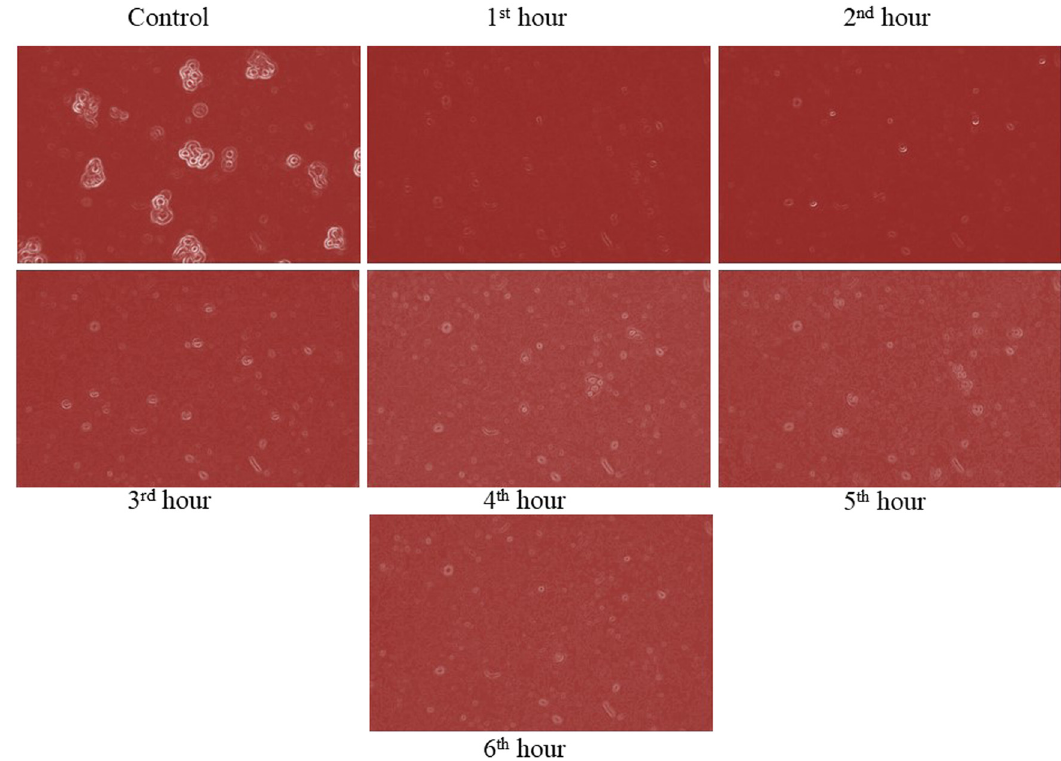
Figure 4: Anticancer activity of pure TiO 2